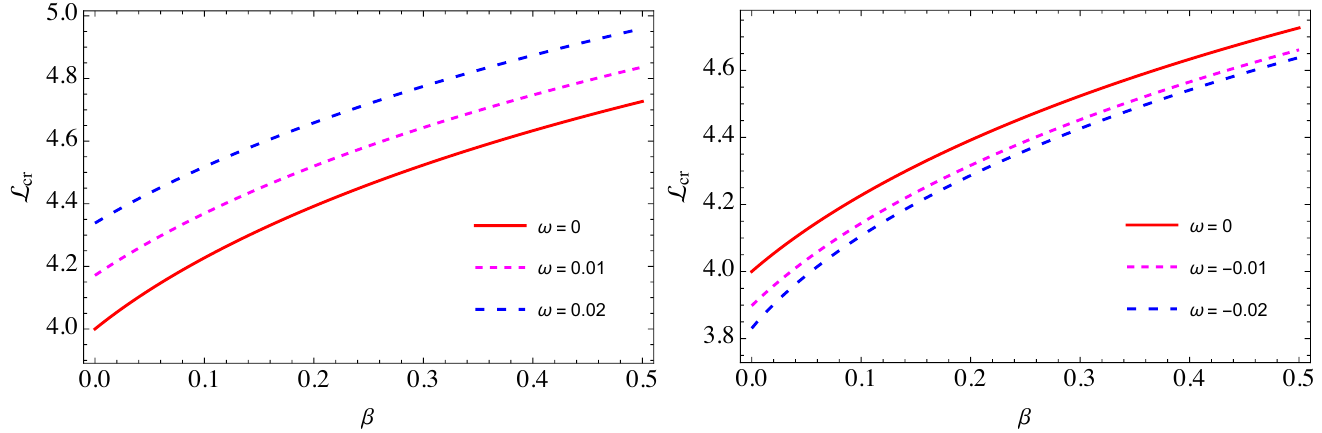
Figure 8. The dependence of critical angular momentum on parameter β with the different values of ω B